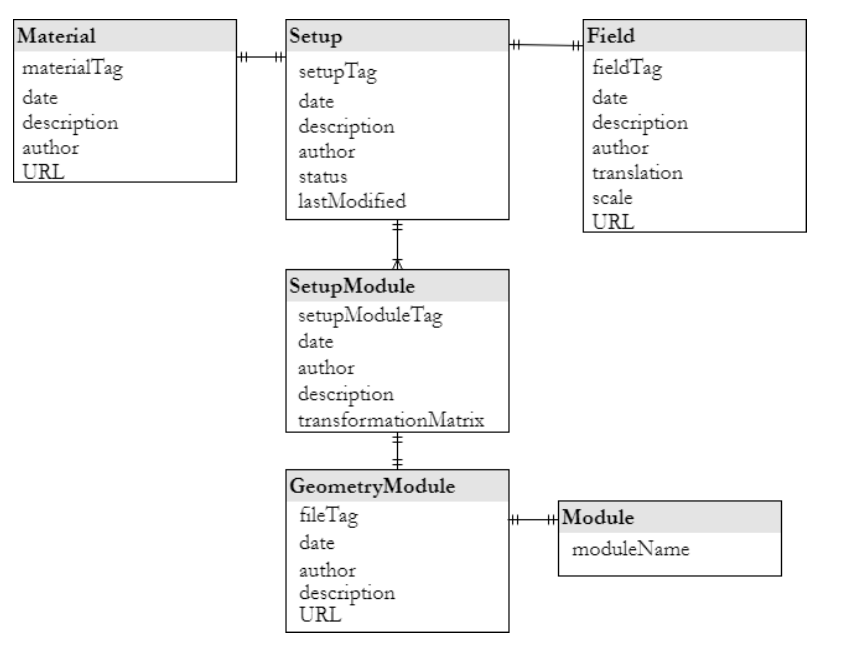
Fig. 3. Logical ER-model of Geometry